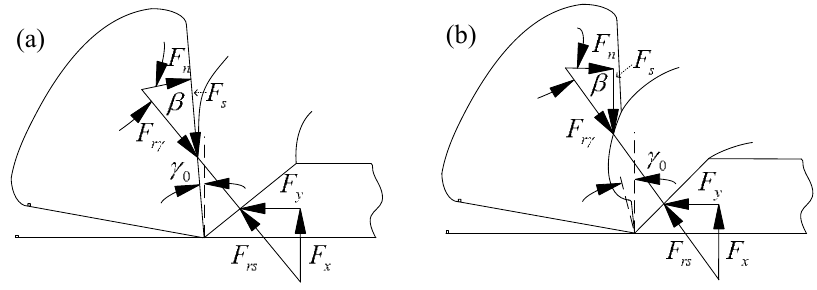
Figure 4. ( a ) Force on the chip of Tool A. ( b ) Force on the chip of Tool B.